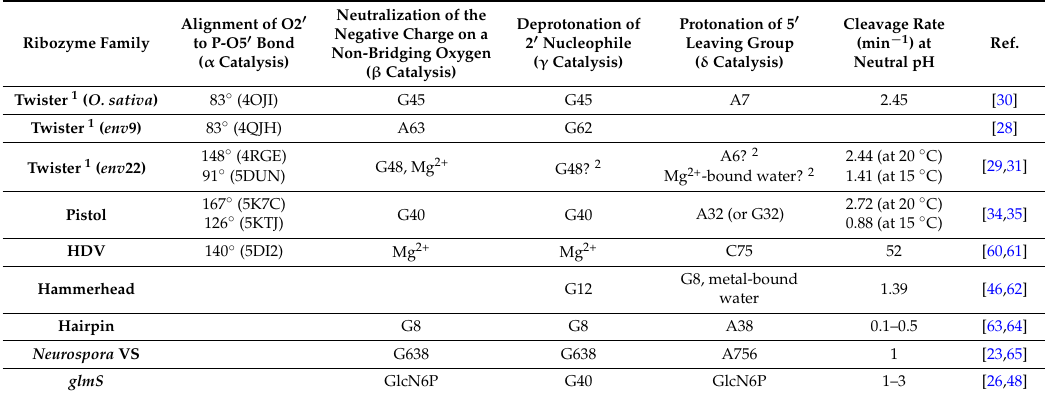
Table 1. The catalytic strategies proposed for self-cleaving